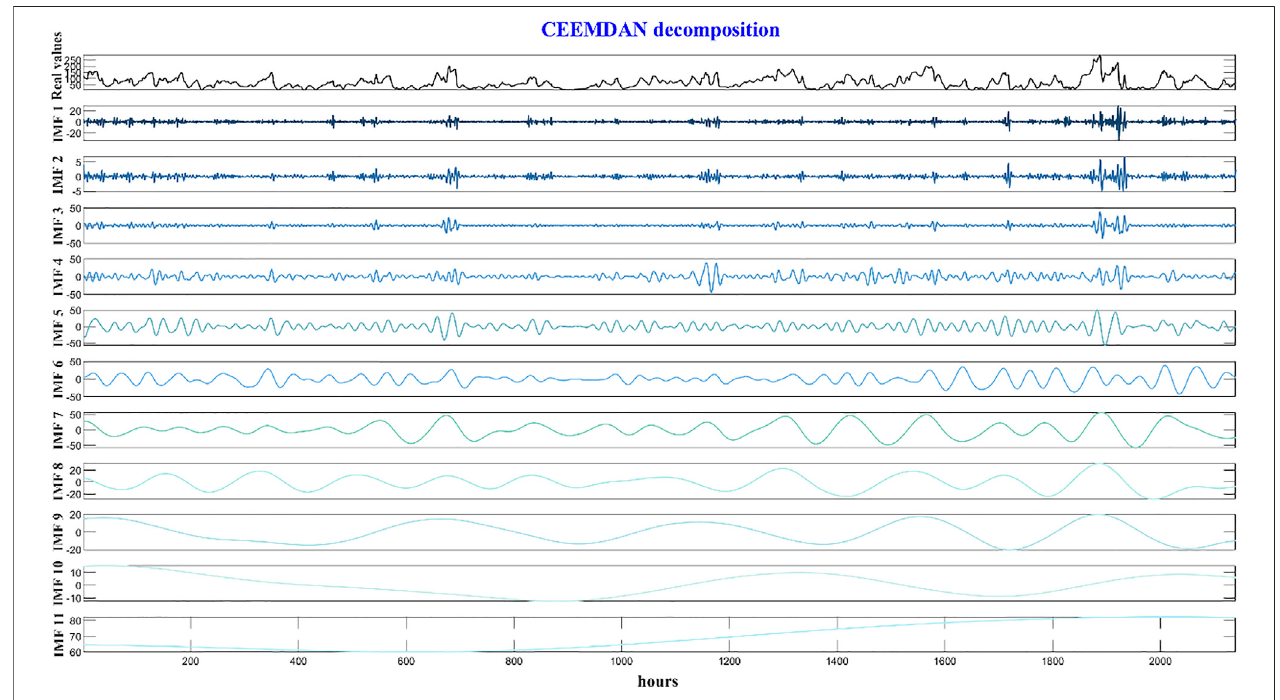
FIGURE 3 | Pollutant series decomposed by CEEMDAN.